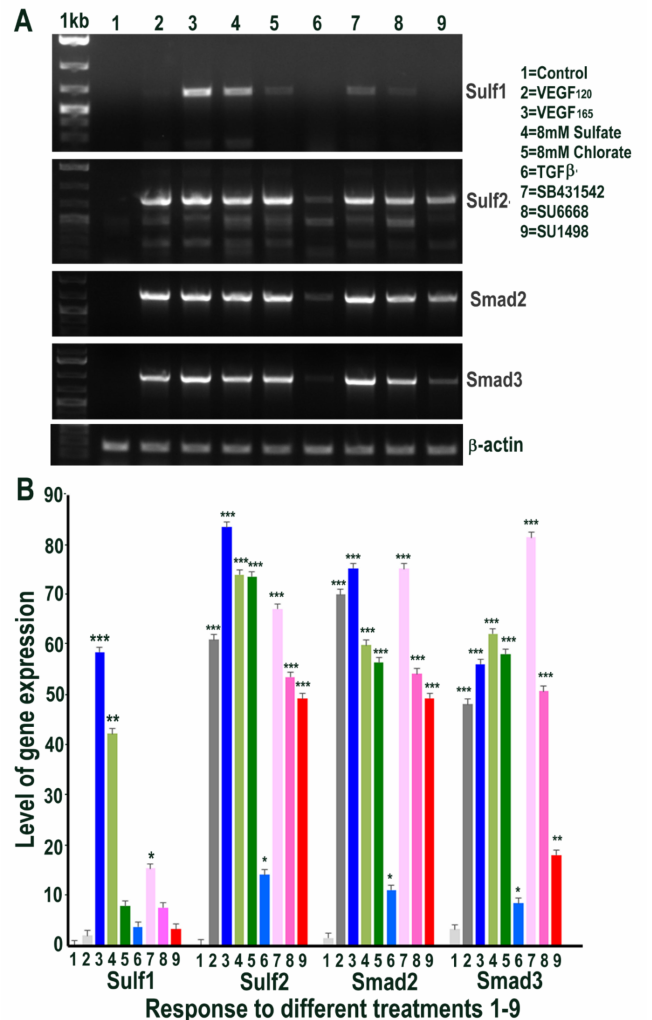
Figure 10. RT PCR analysis of ea926 cells ( A ) and its quantification of Sulf1, Sulf2, Smad2 and Smad3 ( B ) in untreated cells (1) and following treatments with 50 ng/mL VEGF 120 (2) 50 ng/mL VEGF 165 (3) 8 mM sodium sulfate (4) 8 mM sodium chlorate (5) 50 ng/mL TGF β (6) 10 µ M SB431542, TGF β inhibitor (7) 5 µ M SU6668, antiangiogenic RTK inhibitor (8) and 10 µ M SU1498, VEGFR2 inhibitor (9) for 48 h. Error bars = means ± SD; *** p < 0.0001; ** p < 0.001; * p <